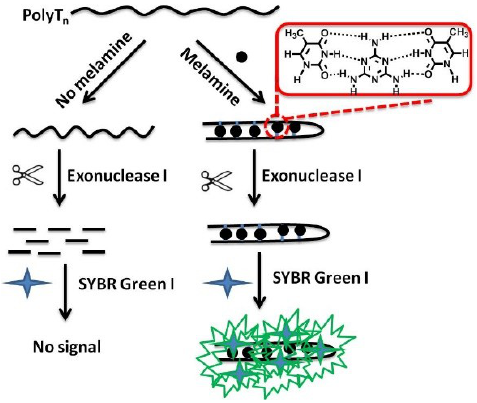
Figure 1. Schematic illustration of the simple and label-free fluorescent method for melamine based on melamine–thymine recognition.